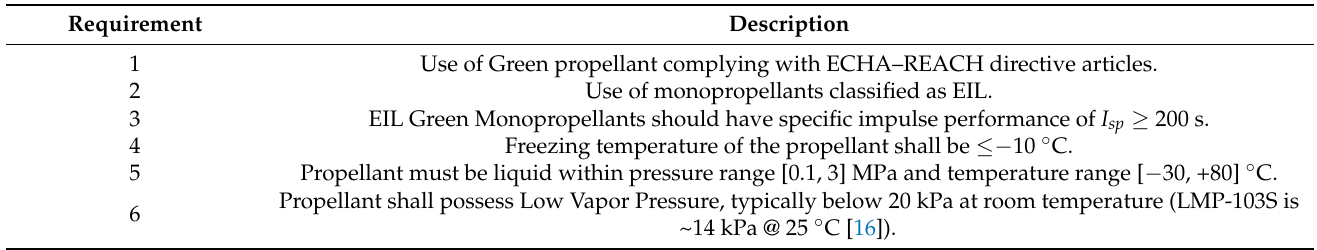
Table 6. Propellants’ trade-off study